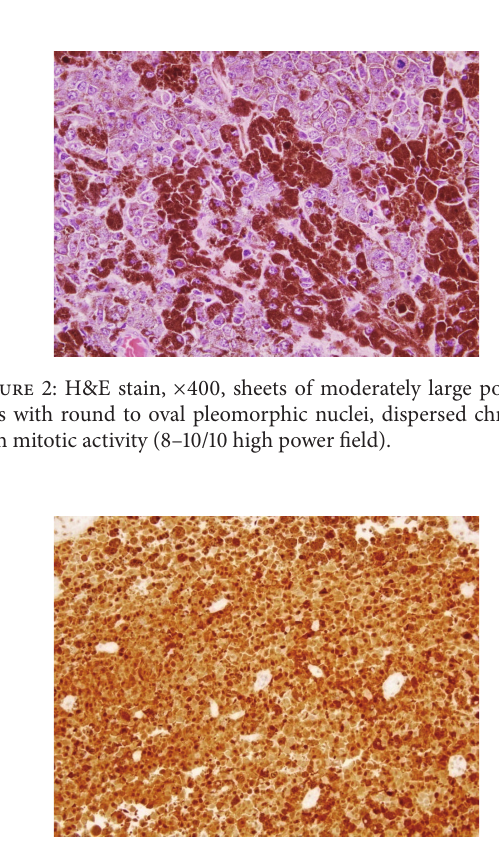
Figure 1: Preop MRI showing the lesion in the left temporal lobe with no dural attachment.